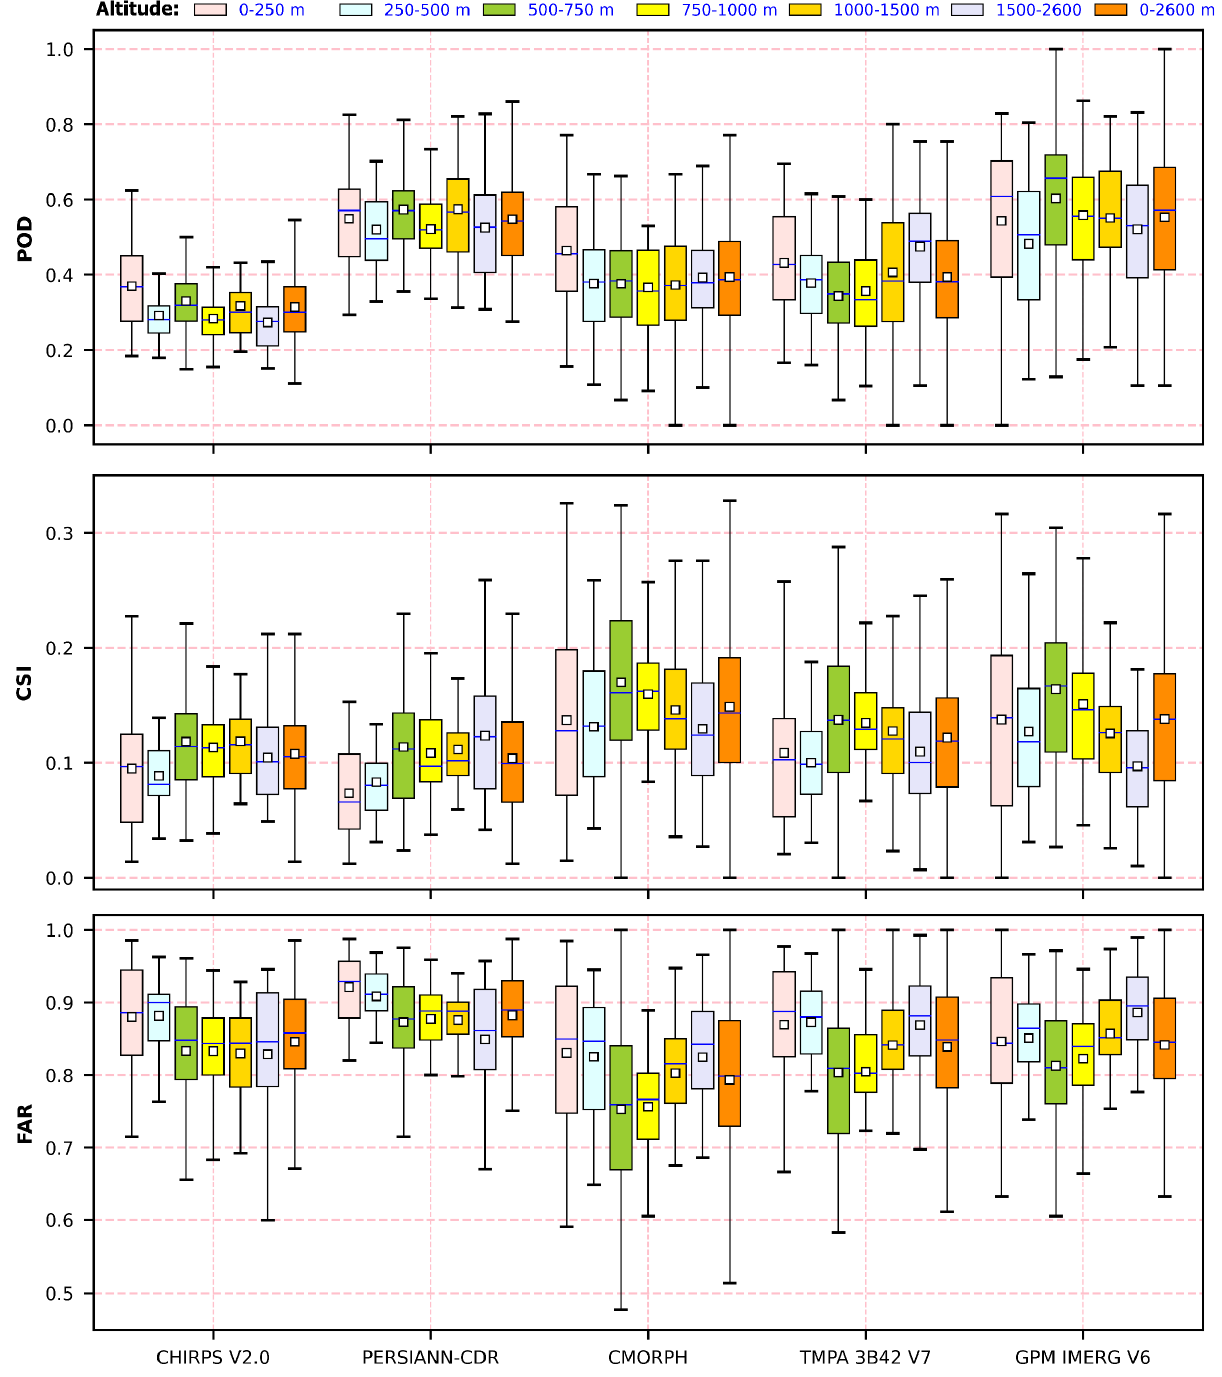
Figure 5. Variation of categorical metrics (POD, CSI, and FAR) with gauge altitude. As shown in Figure 5, the major trend for all satellites except minor anomalies is that the best performance (highest POD, CSI, and lowest FAR) is found at 500–1000 m